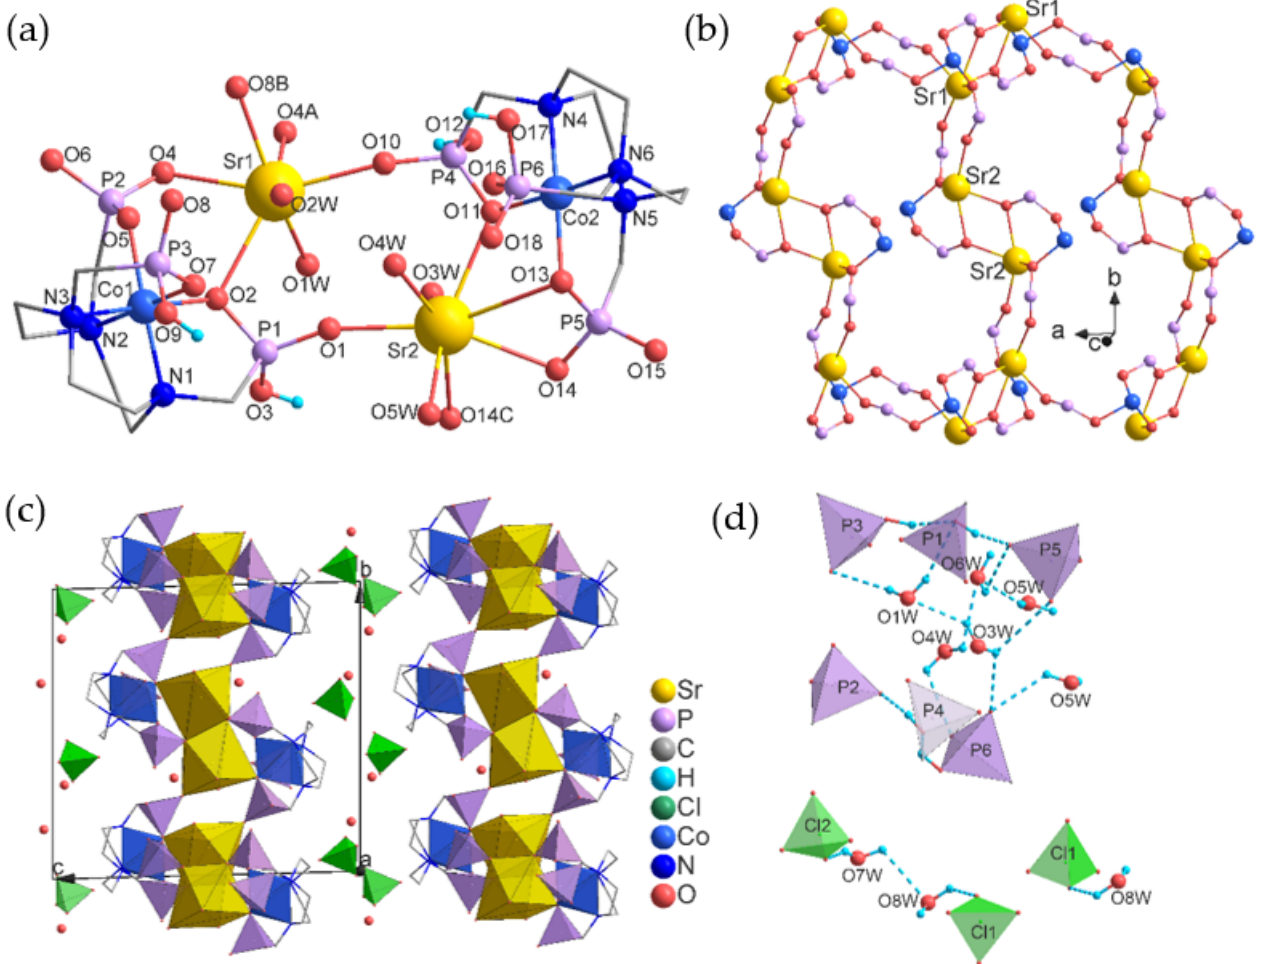
Figure 3. The crystal structure of CoSr · 2H 2 O ; the asymmetric unit ( a ), one inorganic layer ( b ), the three-dimensional packing diagram ( c ), and hydrogen bonds among the water molecules, phospho- nate groups, and perchlorate anions ( d ). All hydrogen atoms are omitted for clarity, except in the protonated phosphonate groups or water molecules.